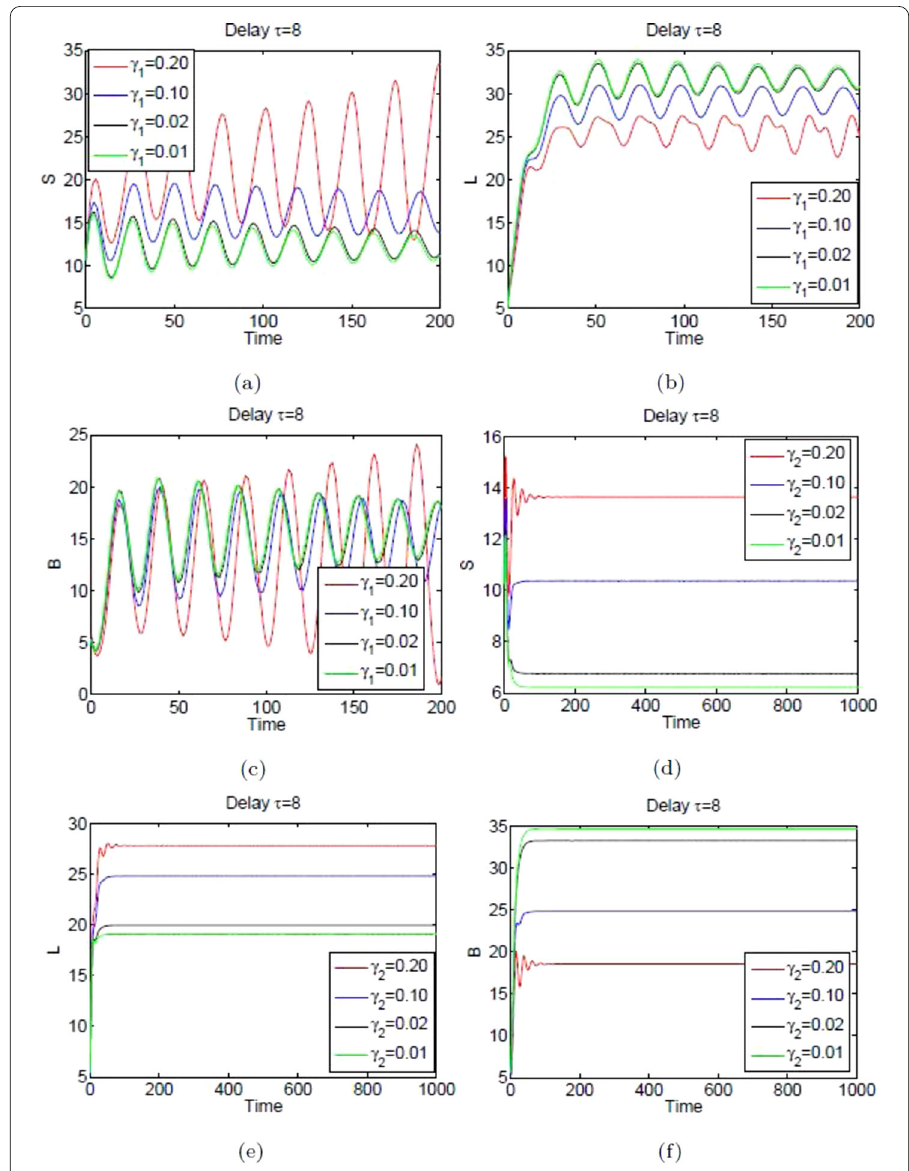
Figure 4 Effect of cure rates ( γ 1 , γ 2 ) at which latent and breaking-out computers cured on system dynamics ( a ) uninfected/susceptible node, ( b ) latent node, and ( c ) breaking-out node with τ = 8. The values of other parameters are same as in